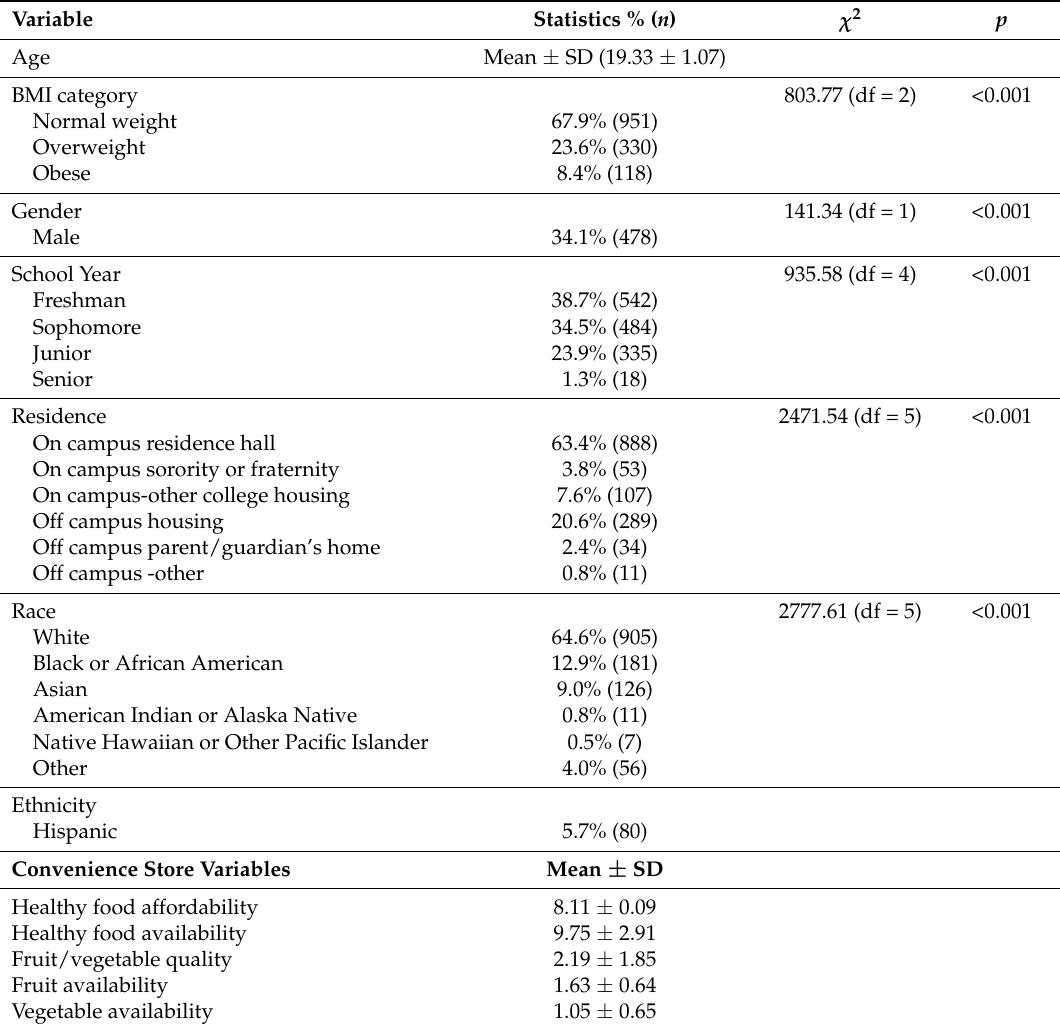
Table 1. Mean and frequencies of demographic variables for college students ( N = 1401) and convenience stores ( n = 41). BMI: body mass index.